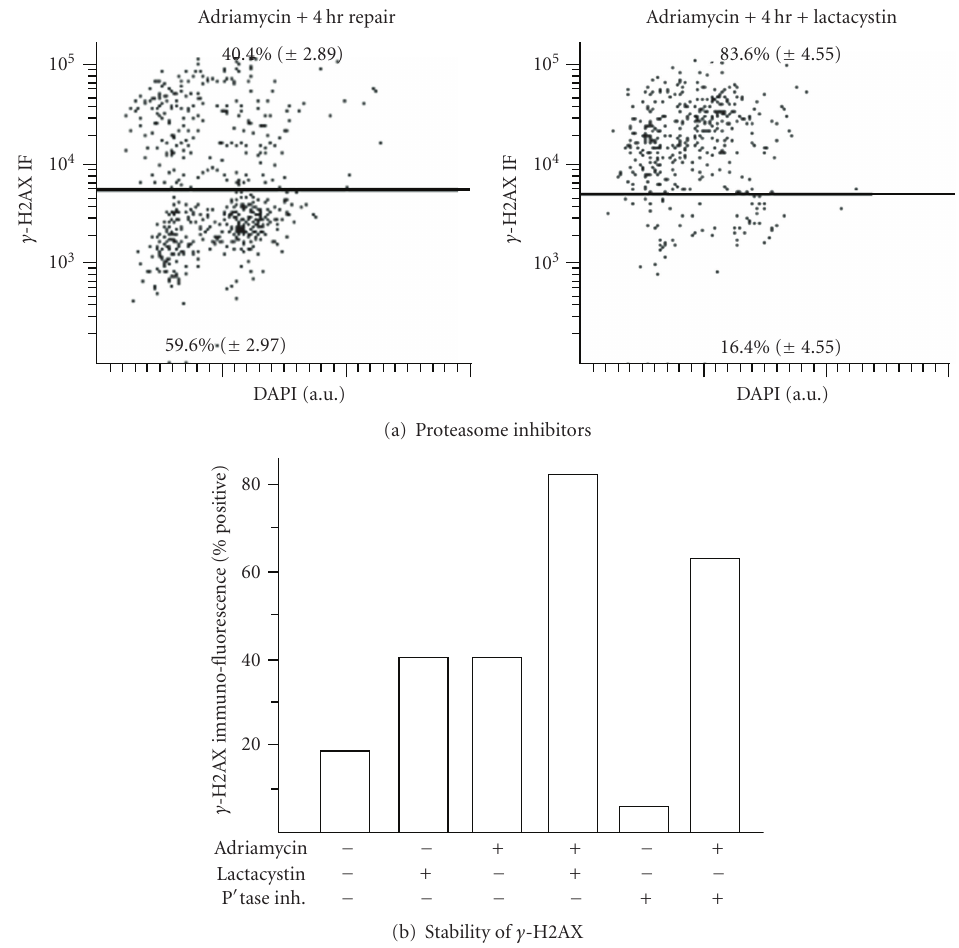
Figure 2: H2AX is dephosphorylated following DNA damage. MCF-7 cells were treated with adriamycin for 1 hour then treated with lactacystin or a phosphatase inhibitor (P’tase inh.) cocktail, as indicated. Cells were fixed and stained for γ -H2AX and quantitated using a Laser Scanning